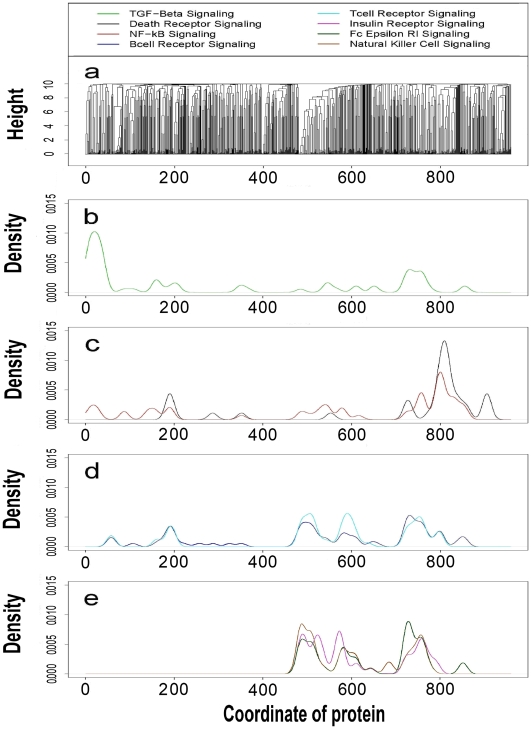
Distribution patterns of eight different signaling pathways.(a) The largest subcluster of 959 proteins is derived from the root of the whole 1729-member cluster. Each protein in this subcluster has a coordinate with respect to its order in the 959 members (from left to right); a pathway distribution is generated from the distribution of its members' coordinates under the bandwidth of 10 (R 2.25; IPA 5.5). (b) Distribution of the TGF-β signaling pathway. (c) Distributions of death-receptor and NF-κB signaling pathways. (d) Distributions of B- and T-cell receptor signaling pathways. (e) Distributions of insulin receptor, Fc epsilon RI and natural killer cell signaling pathways.